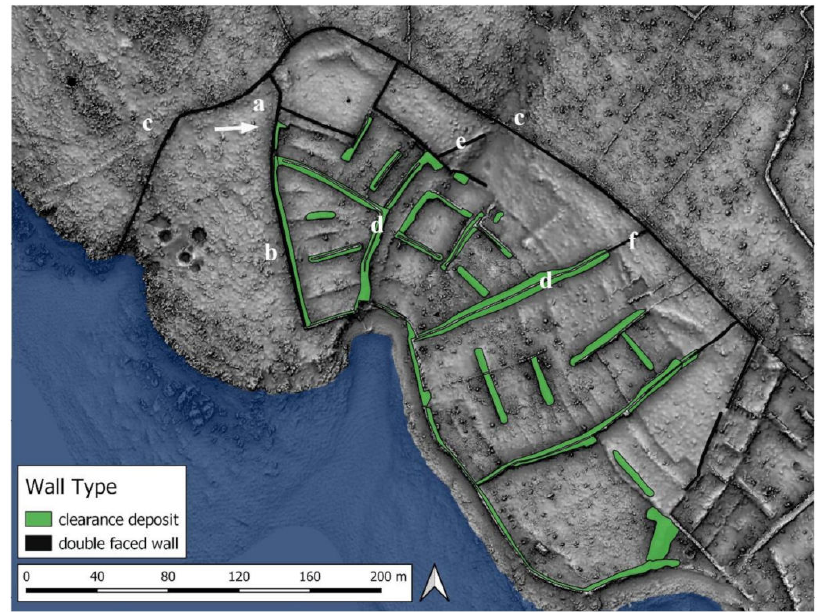
Figure 19. Map of double dry stone walls and stone deposits. The arrow points to the location of Figure 20 (visualization: cVAT). ( a , b ) continuation of the outer wall against which the clearance stones were piled, ( c ) enclosing wall, ( d ) massive stone deposit maybe burying double walls, ( e ) eroded wall older than 1821, ( f ) double wall partly buried by massive stone deposit. See text for further